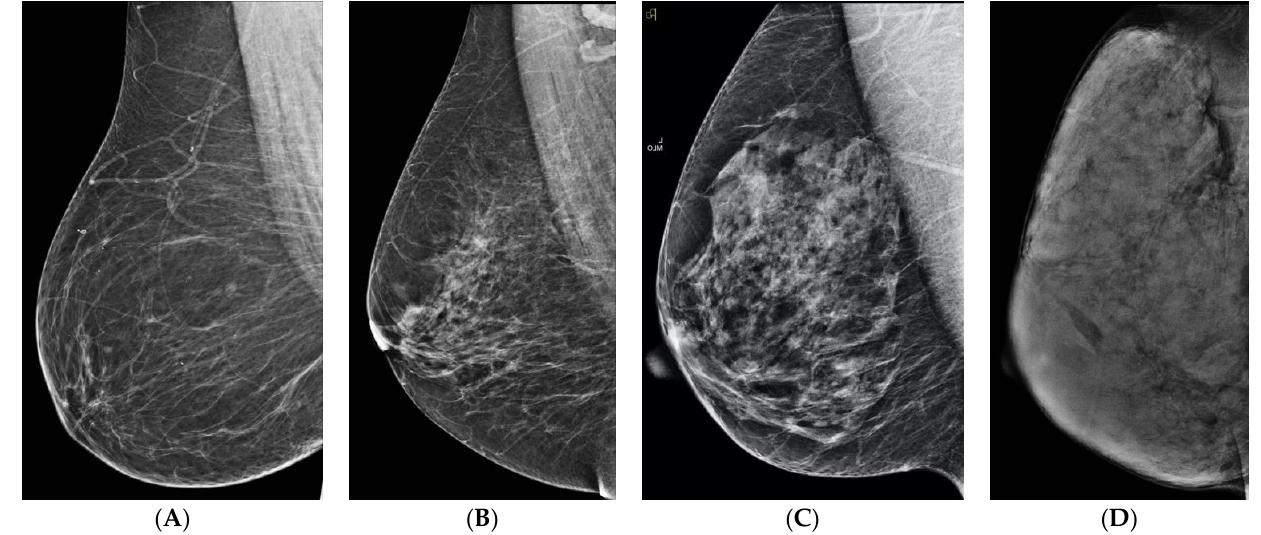
Figure 1. ACR BI-RADS 5th edition density categories: ( A ) Category A — almost entirely fat, ( B ) Category B — scattered fibroglandular densities, ( C ) Category C — heterogeneously dense, ( D ) Category D — extremely dense.